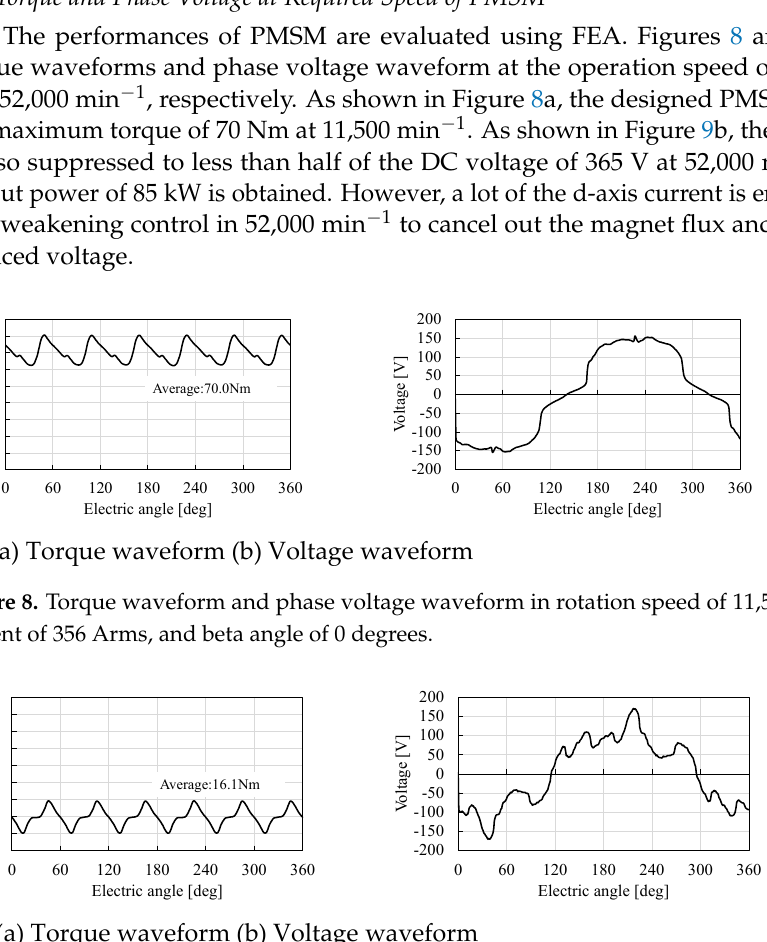
Figure 7. Inductance condition which achieves the demand torque at base speed 11,500 min -1 and maximum speed 52,000 min -1 .